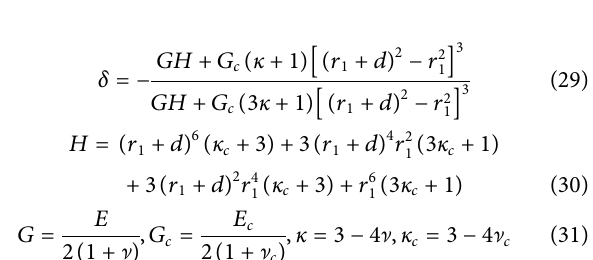
Frontiers in Earth Science |